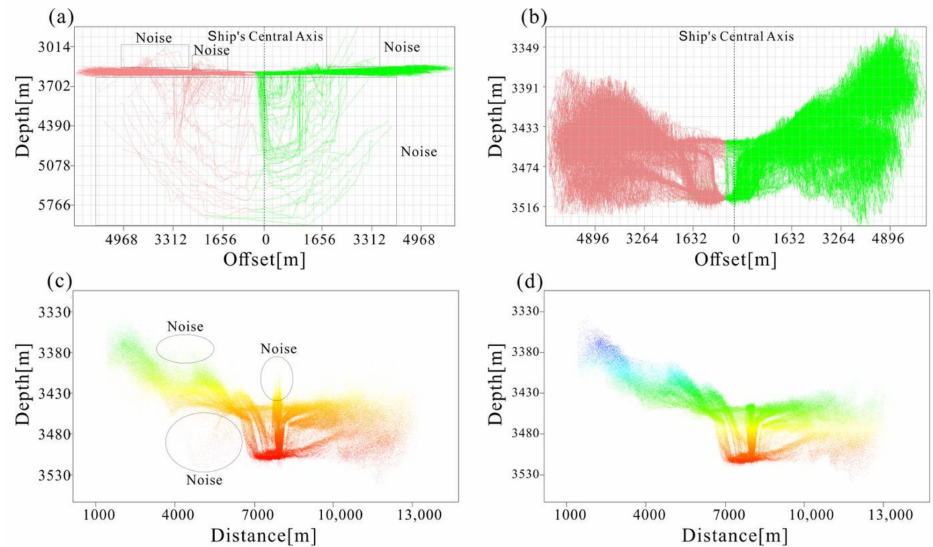
Figure 3. Two optimal swath filtering and surface filtering methods applied on the multi-beam bathymetry data: ( a ) noises in the raw multi-beam bathymetry data; ( b ) the filtering result after the swath filtering after ( a ); ( c ) the surface filtering interface of the bathymetry data after the swath filtering; ( d ) the filtering result after the surface filtering after ( c